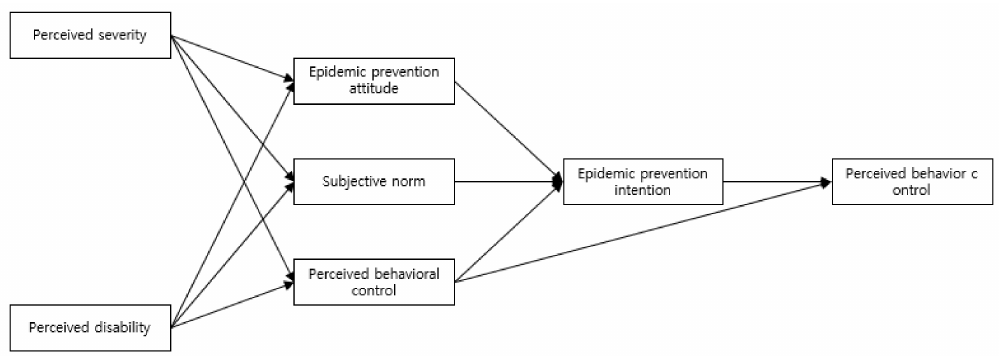
Figure 1. Modified the HBM and the TPB Model for the